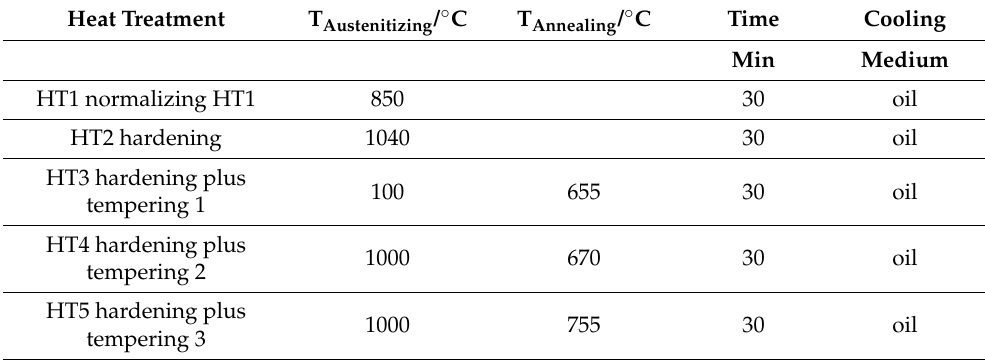
Table 4. X5CrNiCuNb16-4: heat